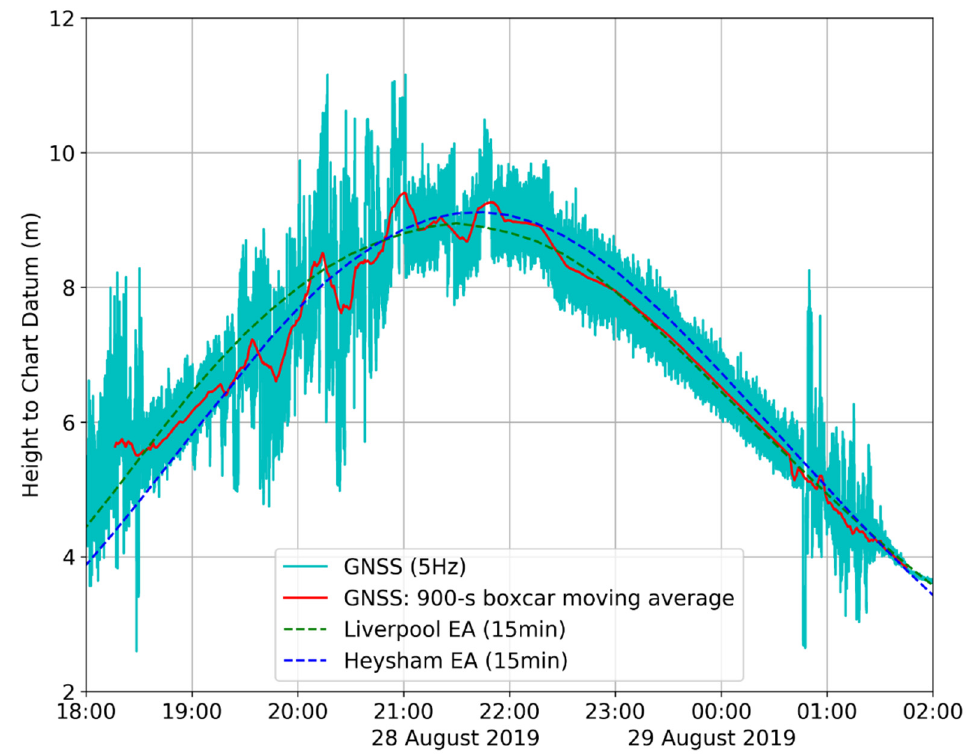
Figure 10. Comparison of the GNSS buoy derived sea levels for tidal cycle A and established tide gauges at Liverpool and Heysham. Note: after high water the 900 s boxcar moving average can be seen to match the 15 min Liverpool tidal data.